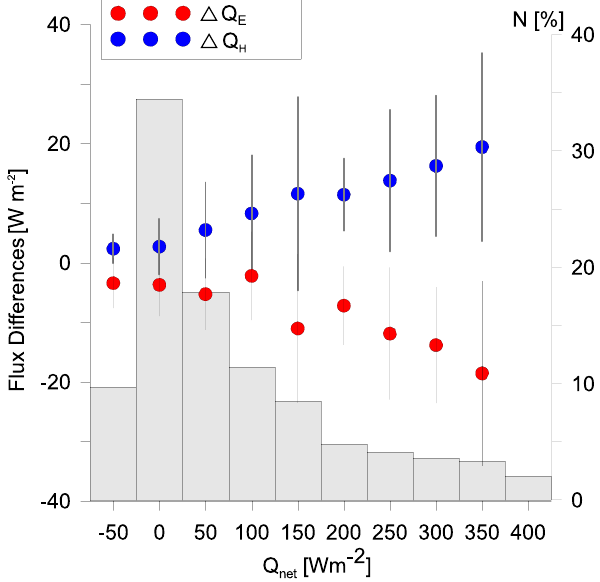
Fig. 8. Differences of sensible 1Q H and latent heat fluxes 1Q E as measured between the stationary station and the second location of the mobile eddy system (7–14 August 2008). The histogram de- picts the distribution of net radiation values over the entire summer period (7 June–30 August